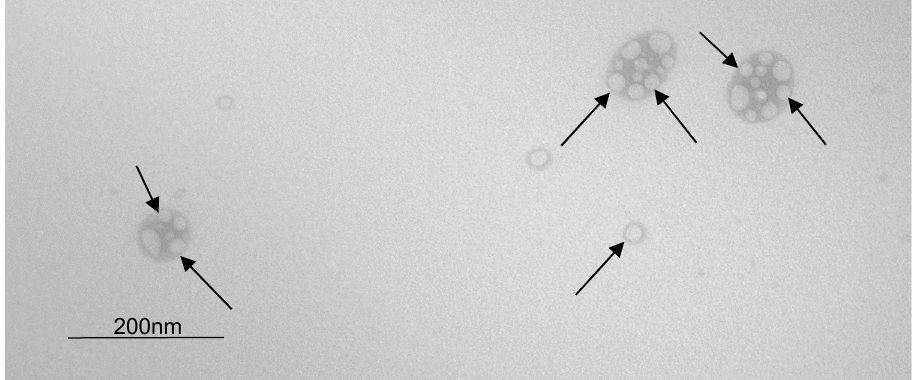
Figure 3. Transmission electron microscopy of NECCs (black arrows) at 71,000× of magnification and 80 kV of accelerating voltage.